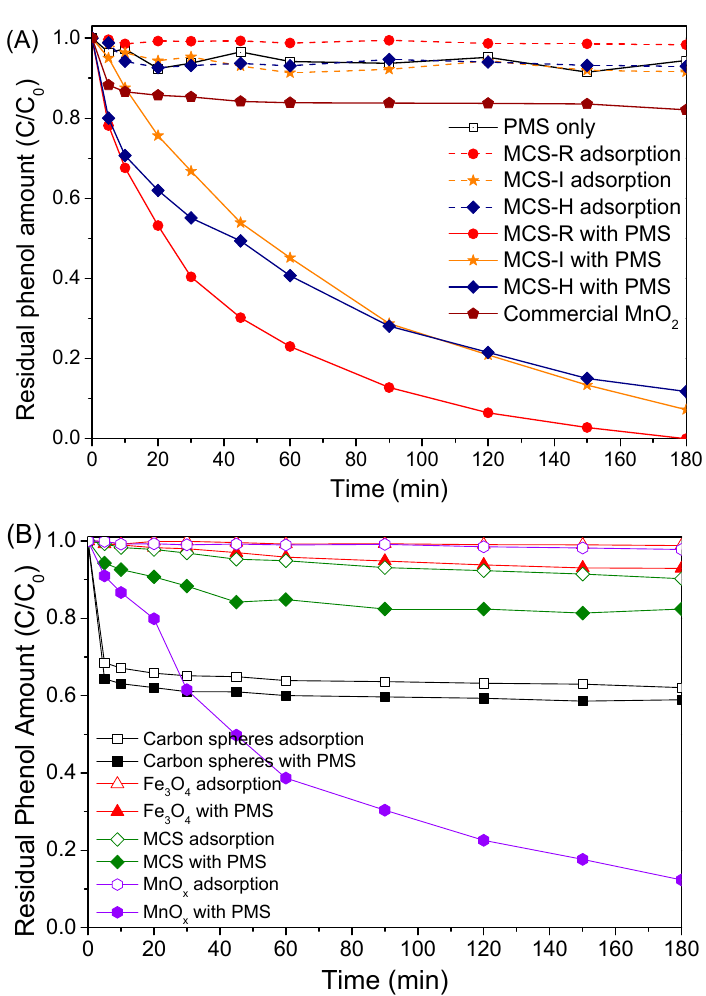
Figure 7. Residual phenol amount using MCS related catalysts ( A ) and other control factors ( B ) ( C / C 0 ) as revealed by high performance liquid chromatography (HPLC) (270 nm wavelength). Reaction condition: [phenol] 0 = 20 mg/L, catalyst loading = 0.2 g/L, Oxone loading = 2.0 g/L, Temperature: 25 °C.